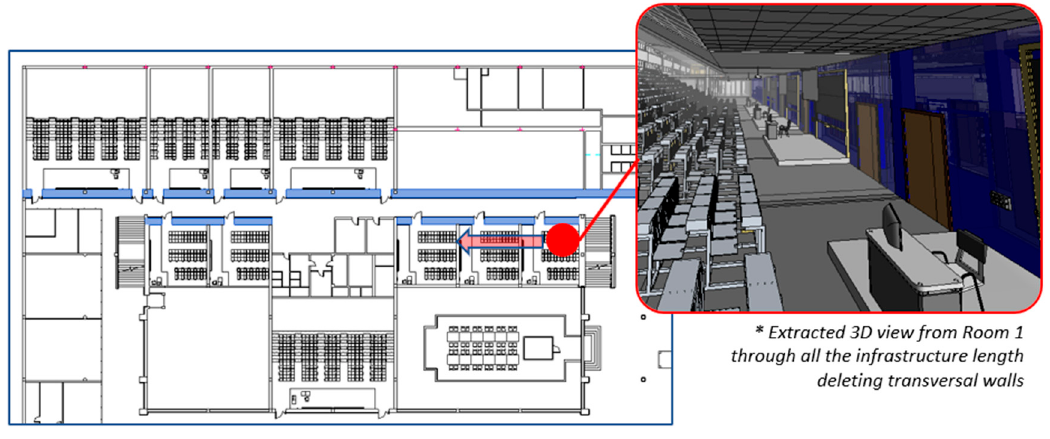
Appl. Sci. 2020 , 10 , x FOR PEER REVIEW